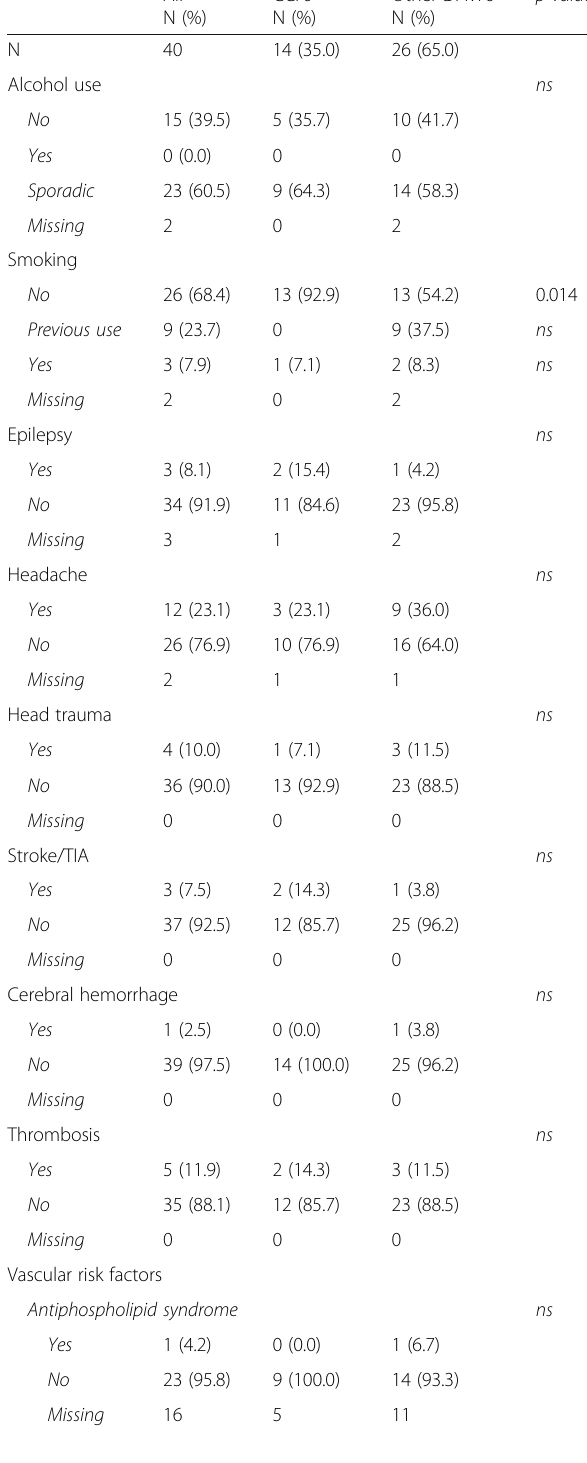
Table 3 Patients ’ history and risk factors. (see page 7)